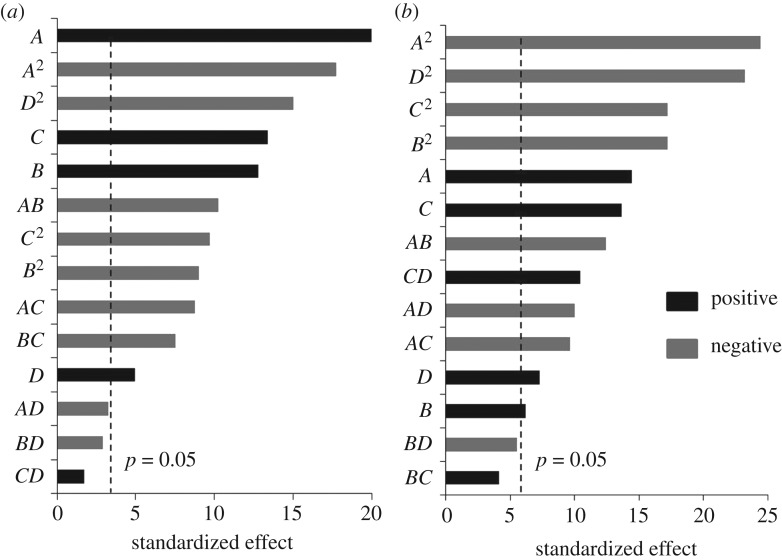
Standardized Pareto chart for β-CRX (a) and biomass (b).